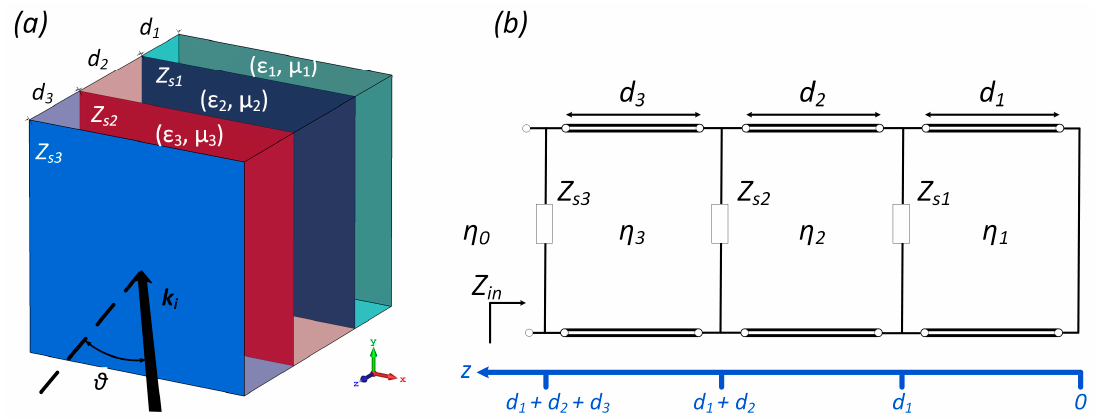
Figure 1. ( a ) A sketch of a three-layered circuit-analog absorber and ( b ) its equivalent circuit model.